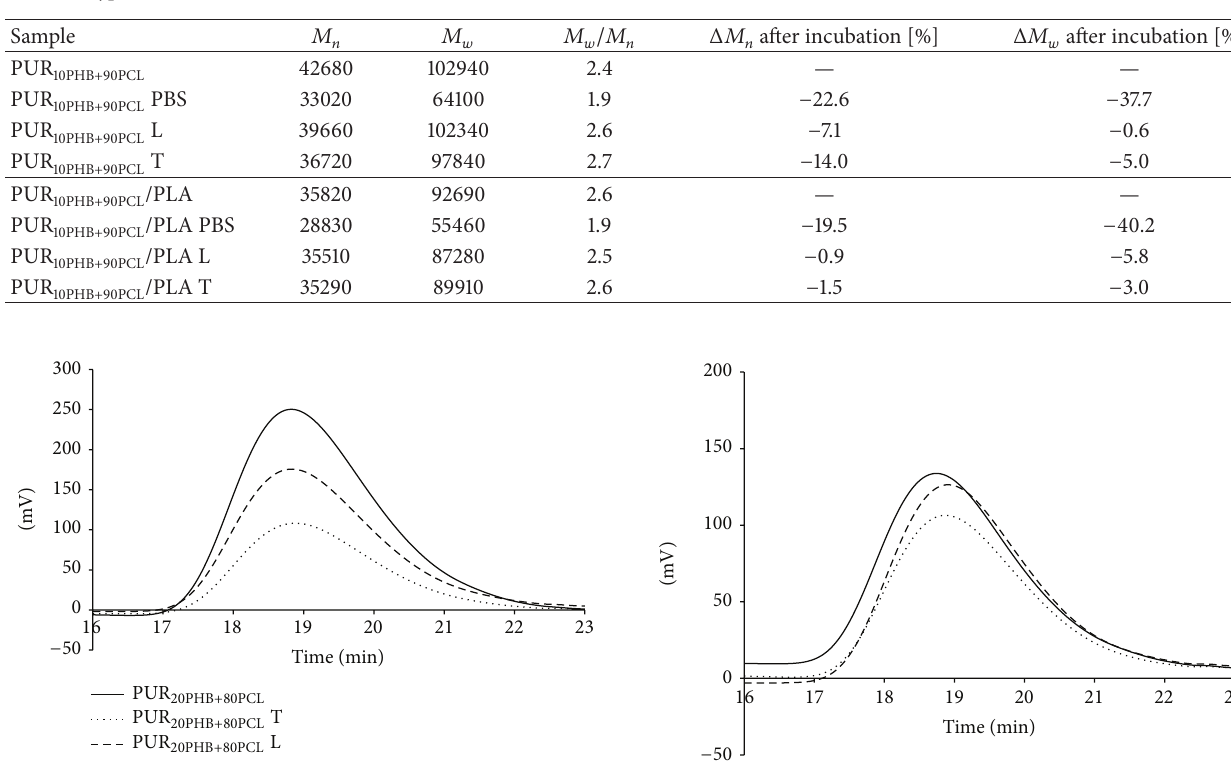
) and its blend (PUR /PLA) before and after incubation in PBS, lipase 10PHB+90PCL 10PHB+90PCL